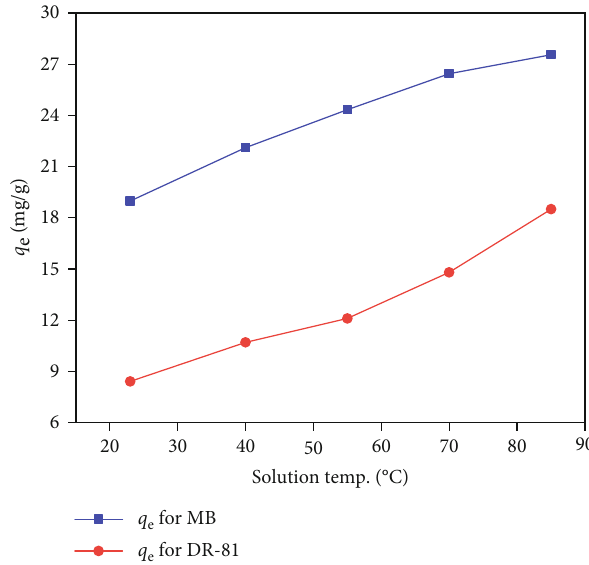
Figure 12: E ff ect of the solution temperature on the adsorption capacity of the synthesized Zn-adeninate bio-MOF for MB and DR-81 (contact time = 10 min for MB and 30min for DR-81, pH = 7 , bio-MOF dosage = 0 : 5 g L − 1 for MB and 1g/L for DR-81, initial dye concentration = 10 ppm, and stirring speed = 300 rpm).